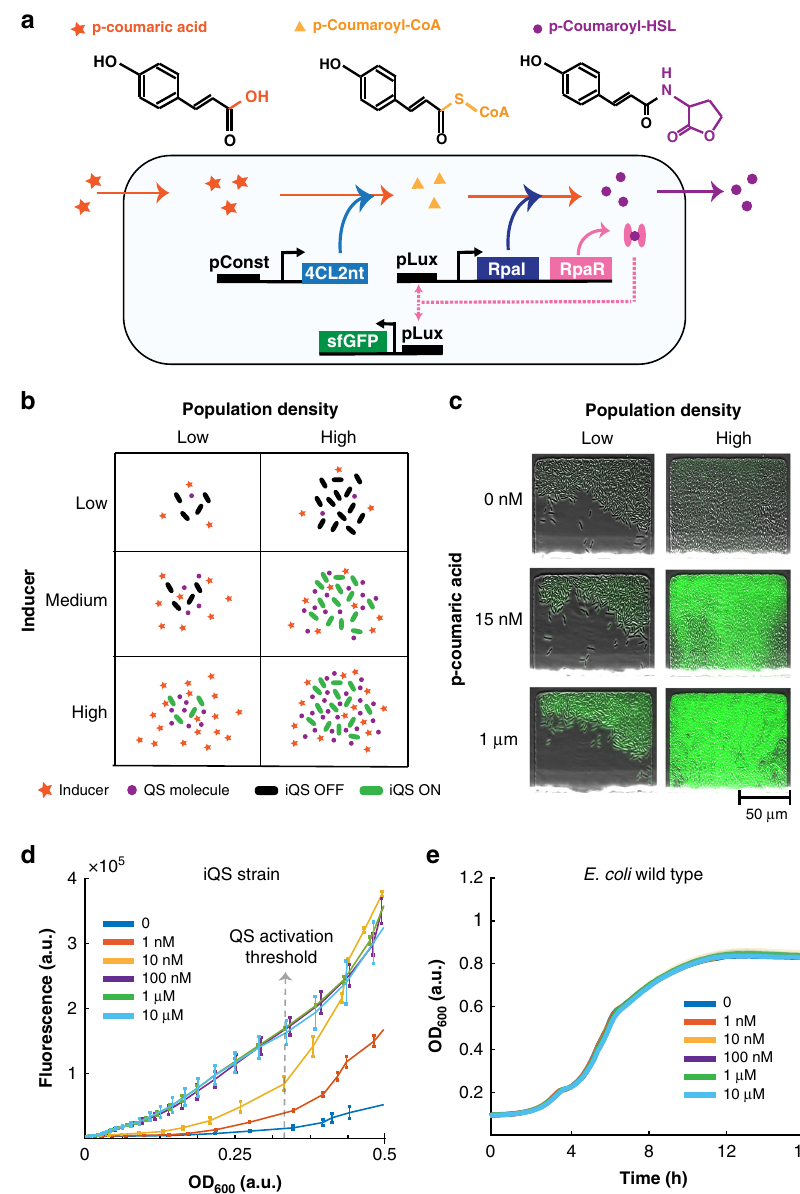
Fig. 1 Design and characterization of the p-coumaric acid mediated iQS strain. a Diagram of the iQS genetic circuit. The chemical structures of the molecules involved in the synthesis of the QS molecule are shown at the top. b Diagram to illustrate predicted dynamics associated with the inducible quorum sensing system as a function of population density and external inducer concentration. c Fluorescence microscopy images showing a composite of phase-contrast and GFP fl uorescence in micro fl uidic traps. The data from the raw fl uorescence values re fl ect the iQS dynamics predicted in part b. d Data from microplate reader experiment obtained by culturing the iQS strain in different p-coumaric acid concentrations. All data points represent mean ± standard deviation of three independent replicates. e Microplate reader experiment data obtained by culturing the wild-type E. Coli strain in a range p- coumaric acid concentrations. All data points represent mean (solid line) ± standard deviation of three independent replicates (shaded areas). Source data are provided as a Source Data fi